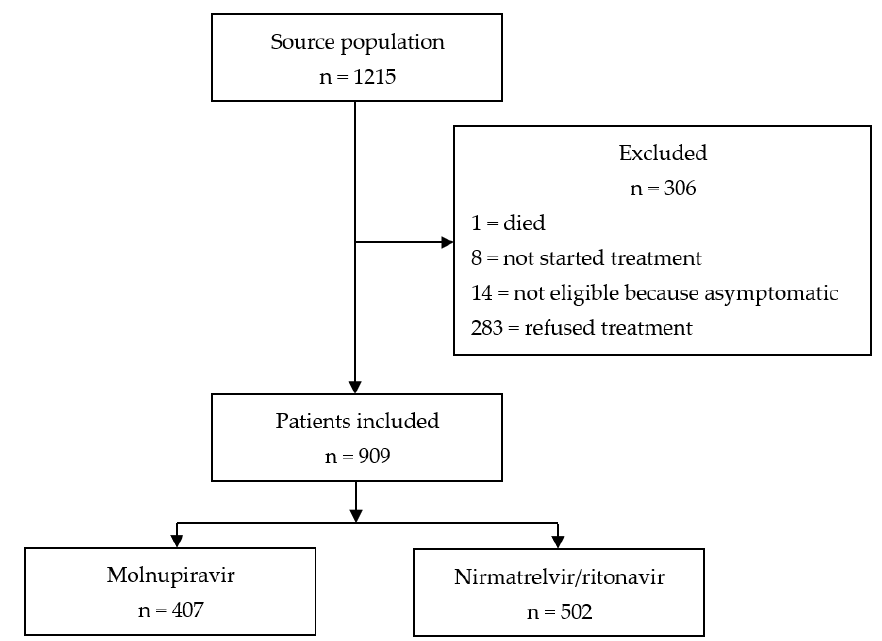
Figure 1. Patient’s flow.